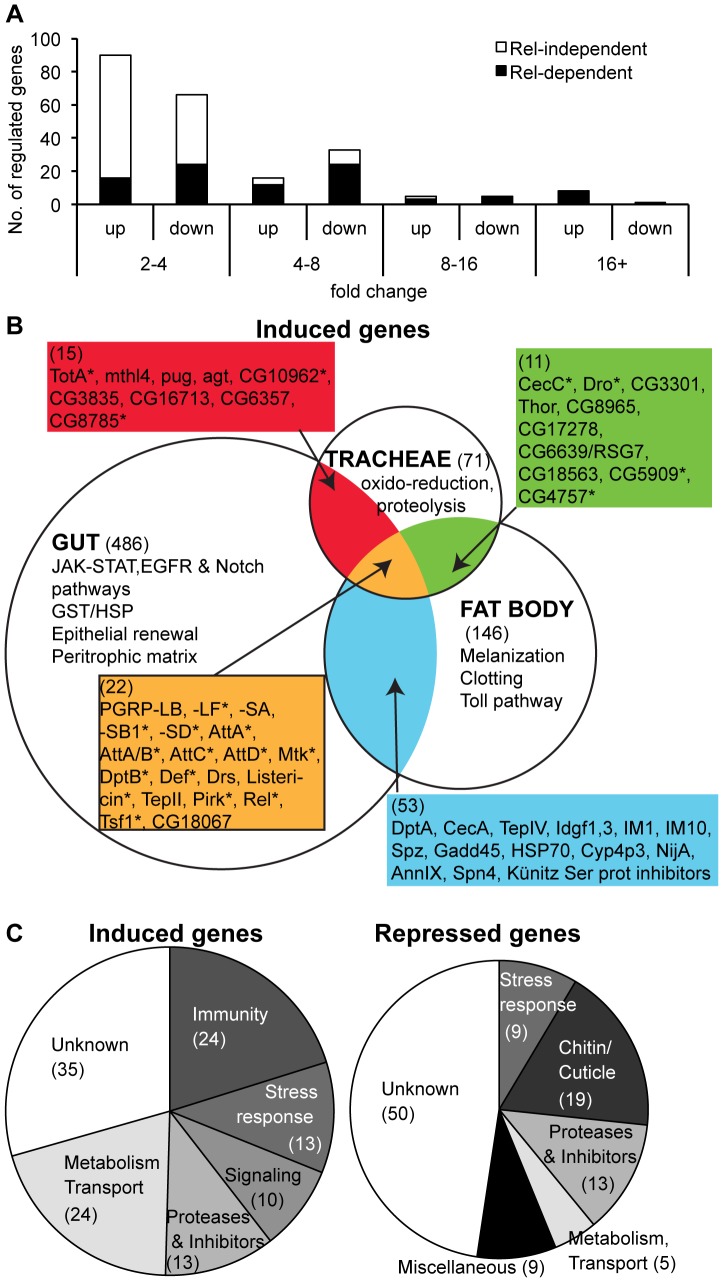
Microarray characterization of the tracheal immune response in wild-type larvae.
A. Distribution of regulated genes, based on their up or down-regulation and their fold change in the microarray. Black and white bar portions represent the genes whose expression is affected or not affected in RelE20 respectively. B. Comparison of the distribution of genes up-regulated in the tracheae upon Ecc15 bacterial infection to that of genes induced in the gut upon Ecc15 ingestion and in whole flies upon septic injury with Ecc15
[40], [47]. * indicates that the gene expression is affected in RelE20. The number of genes induced in each tissue is indicated in brackets. C. Repartition of induced (left) and repressed (right) genes in defined categories of gene ontology.